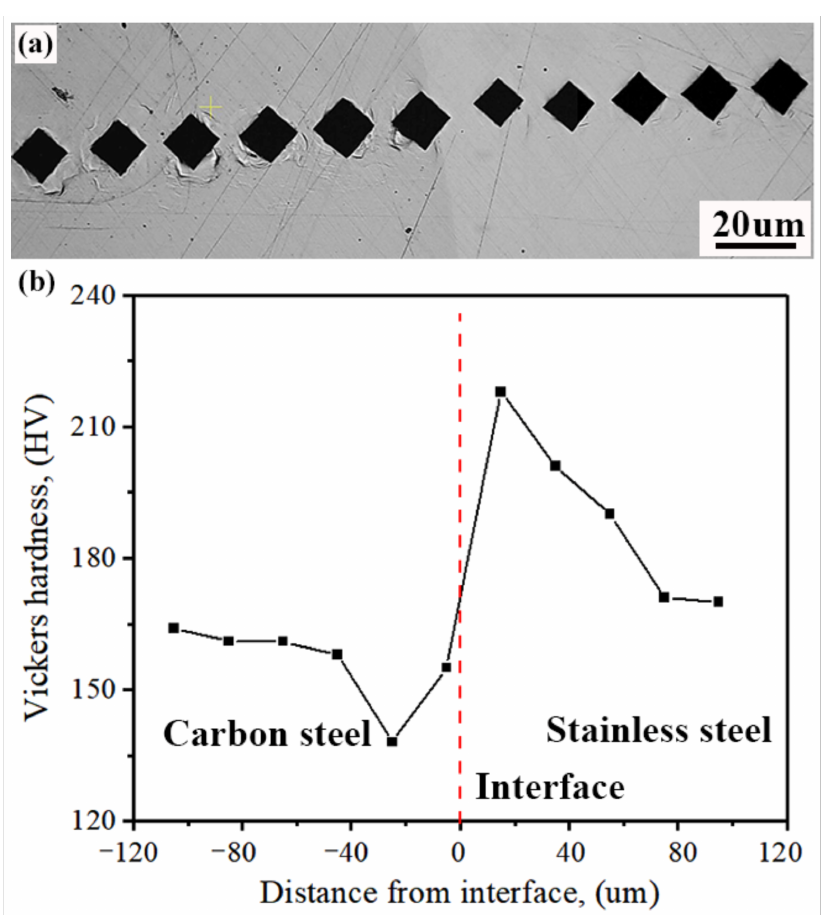
Figure 13. Results of microhardness tests on composite interfaces: ( a ) location of test points; ( b ) microhardness variation curve.